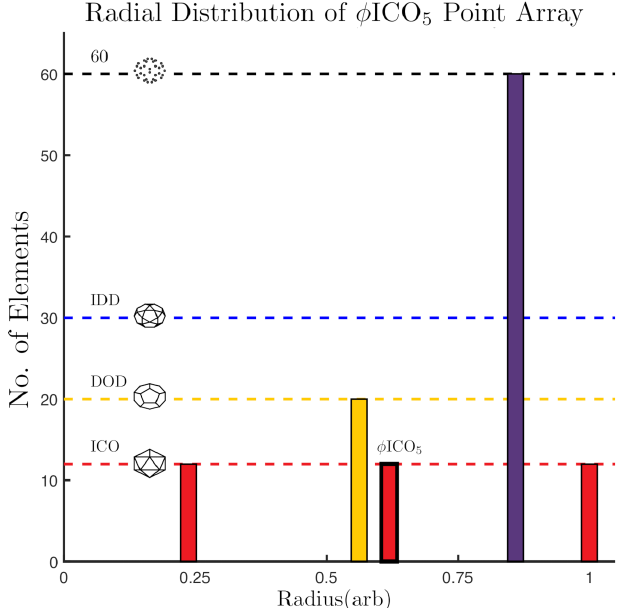
Figure 5. A histogram of the point array elements by radii in arbitrary units. The base array φ ICO has a bold outline around the 12 points at r ∼ 0.64. The gauge points are on the 5-fold axes (Gauge Point 1). In total there are now 3 icosahedrons and one dodecahedron, all with different radii. There is also a layer of 60 points along the 5-2 great circle of the AU; due to the 60 rotations of the icosahedral group, any point not located on a symmetry axes will produce 60 points after the symmetry is applied (Figure 4). The cardinality or size of this point array is 116 = 12 ( ICO ) + 20 ( DOD ) + 12 ( ICO ) + 60 ( 5-2 ) + 12 ( ICO )